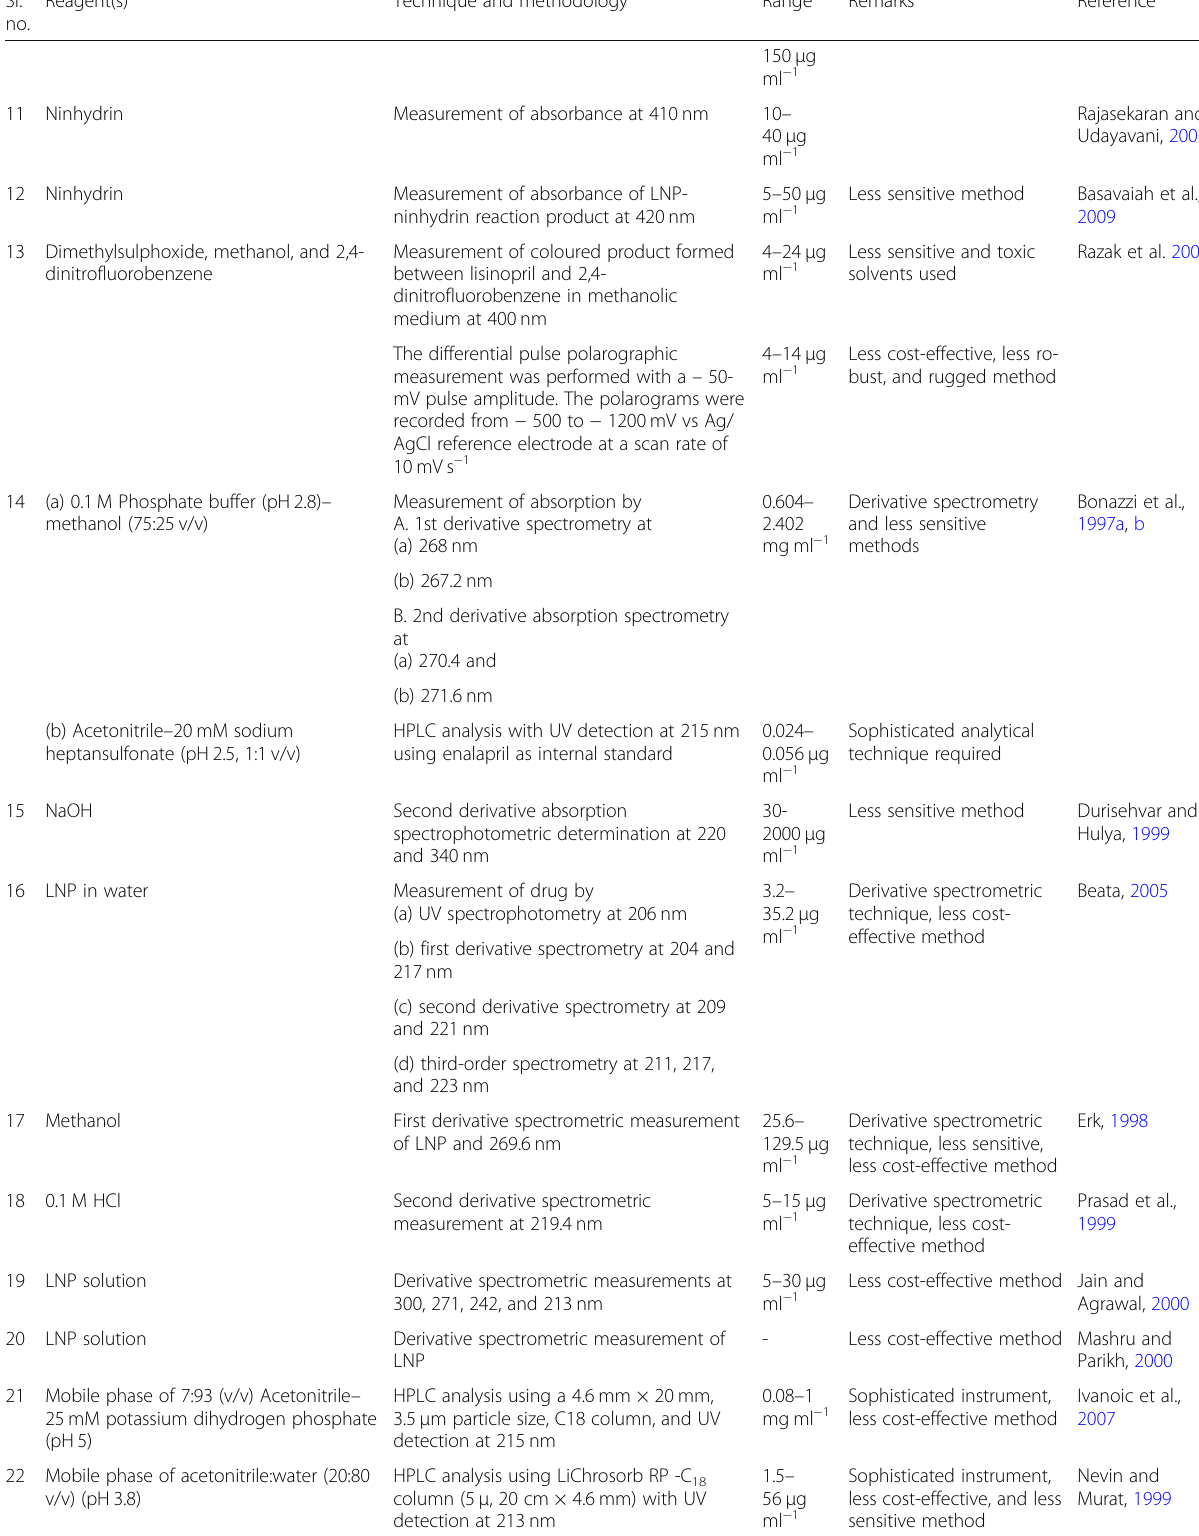
Table 1 Performance characteristics of existing methods of LNP (Continued) Sl. no.